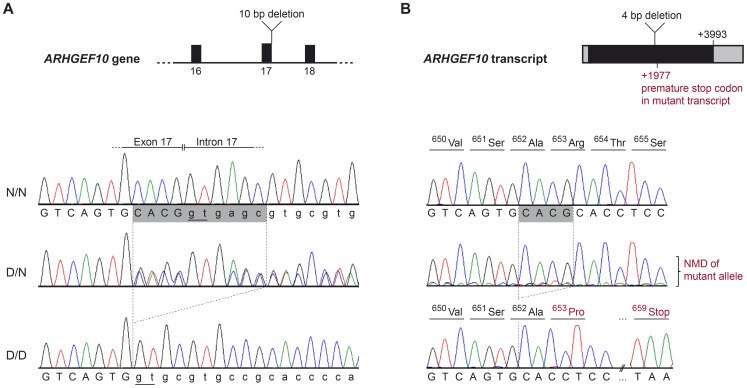

ARHGEF10 mutation analysis.(A) Genomic DNA. Electropherograms of the ARHGEF10 c.1955_1958+6delCACGGTGAGC mutation. Representative sequence traces of PCR products amplified from genomic DNA of 3 dogs with the different genotypes are shown. (B) Transcript. Electropherograms of RT-PCR using primers in exon 17 and 19. Representative sequence traces of RT-PCR products amplified from cDNA of 3 dogs with the different genotypes are shown. Note the underrepresentation of the mutant transcript in the heterozygous dog, which is probably due to nonsense mediated decay (NMD). Both the normal and the new splice site created by the deletion are underlined (Panel A); the cryptic splice site in the deletion allele creates a cDNA missing only four base pairs, which creates a frame shift and predicts a premature stop codon within seven amino acid residues (Panel B).